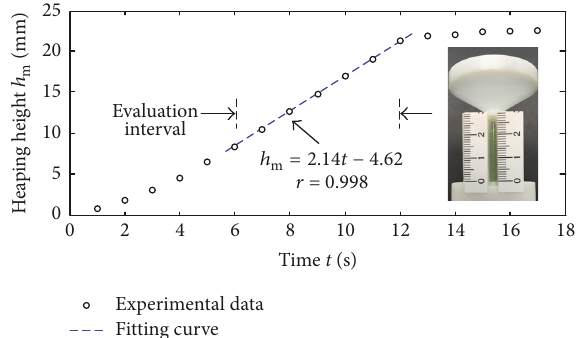
Figure 5: Relationship between the experimental heaping height and time.